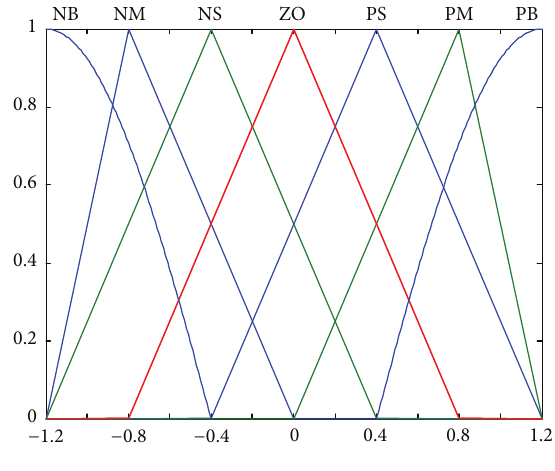
Figure 3: Membership function for Δ𝐾 𝑃 .